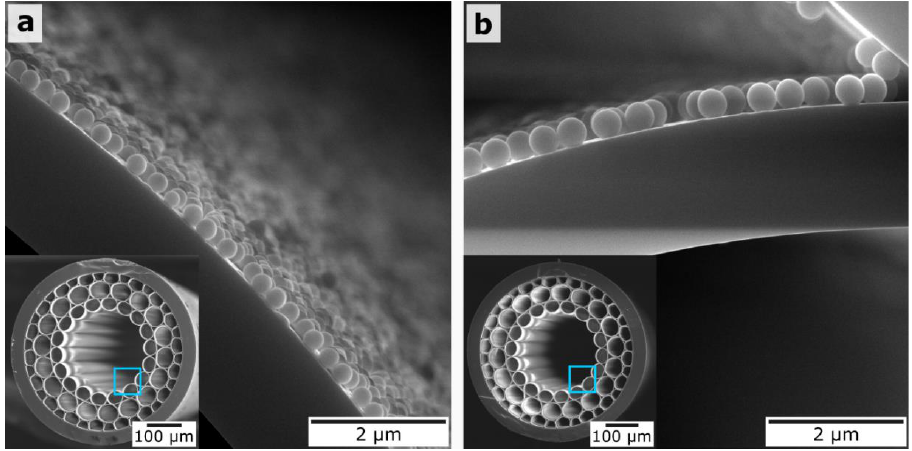
Figure 5. SEM images of MOW end faces and magnified capillary surfaces. ( a ) MOW sample after deposition of one layer of 300-nm silica particles. ( b ) MOW sample after deposition of one layer of 420-nm silica particles.